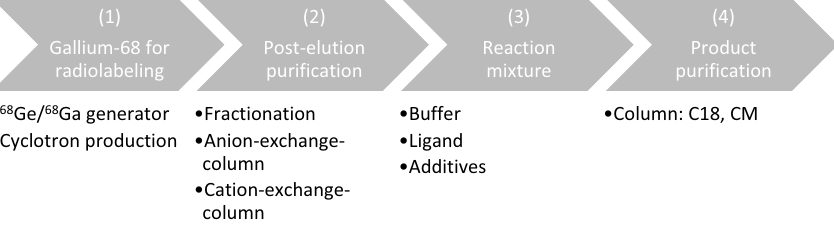
Fig. 3 Schematic overview of automated radiolabeling